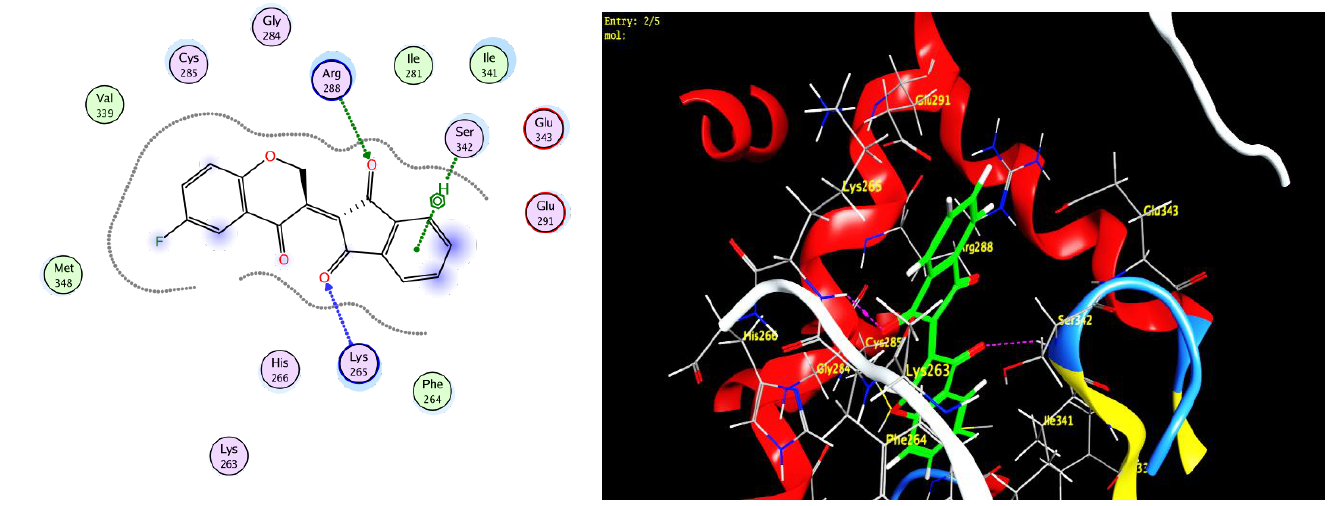
Figure 8. 2D and 3D docking of compound 12b with AKR1B10.